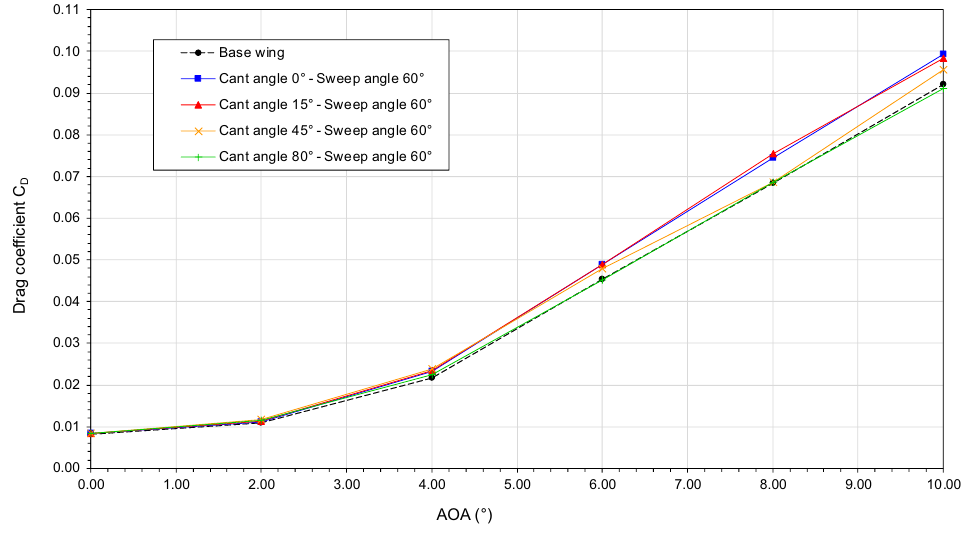
Figure 18. Drag coefficient versus angle-of-attack at Mach number 0.8395, winglet sweep angle 60 ◦ and different values of cant angle.